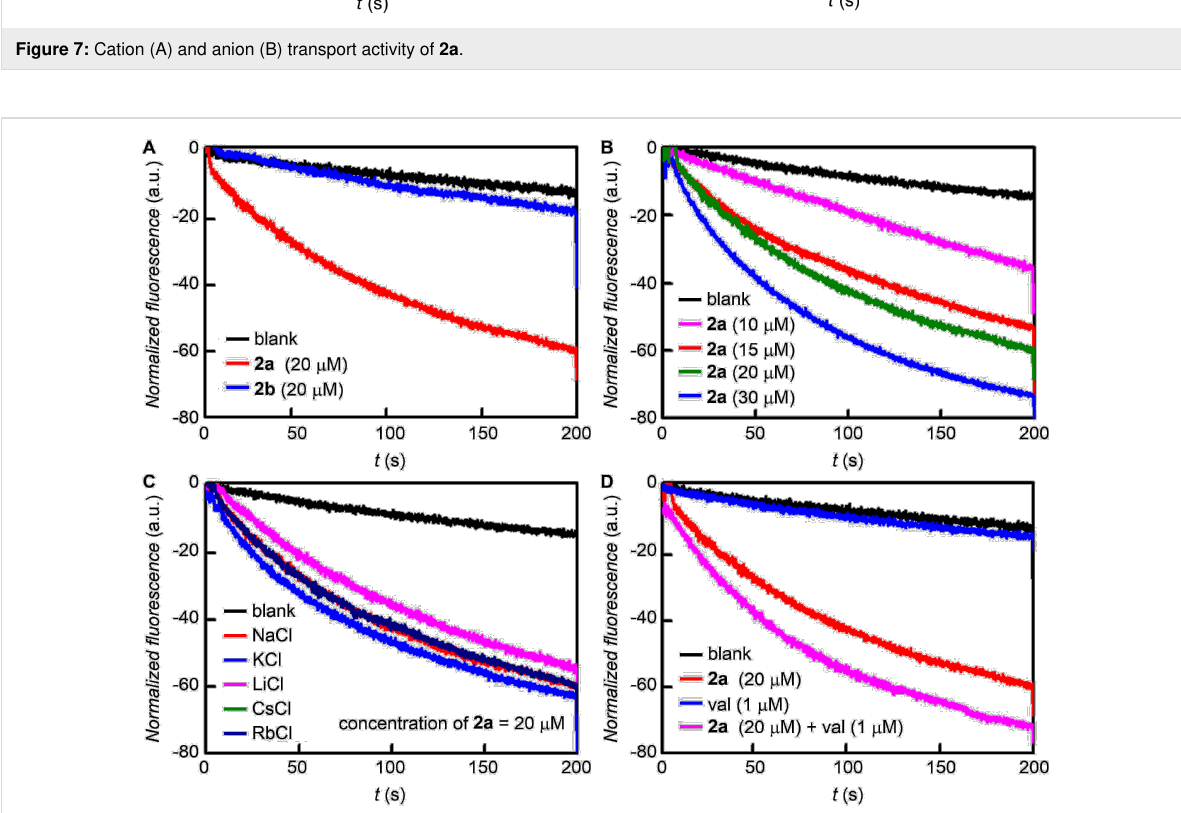
Figure 8: Comparison of the ion transport activity of 2a and 2b at 20 µM across EYPC-LUVs lucigenin (A). Concentration dependent activity of 2a across EYPC-LUVs lucigenin (B). Transport activity of 2a (20 µM) by changing extravesicular cations (C). Transport activity of 2a (20 µM) in the presence and absence of valinomycin (1 µM) across EYPC-LUVs lucigenin